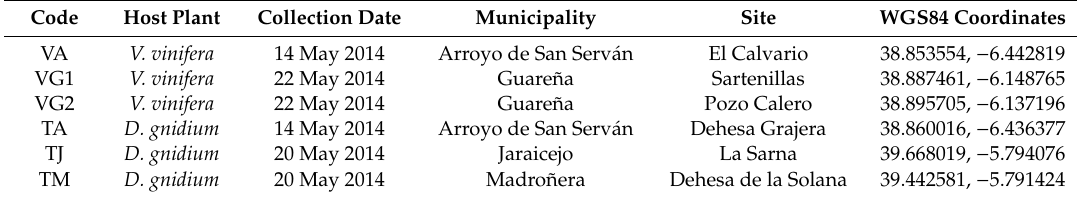
Table 1. Moth larval host-plants and field collection sites.